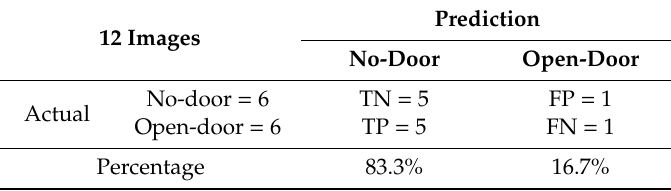
Table 2. Confusion matrix. (TN: true negative, TP: true positive, FP: false positive, FN: false negative).